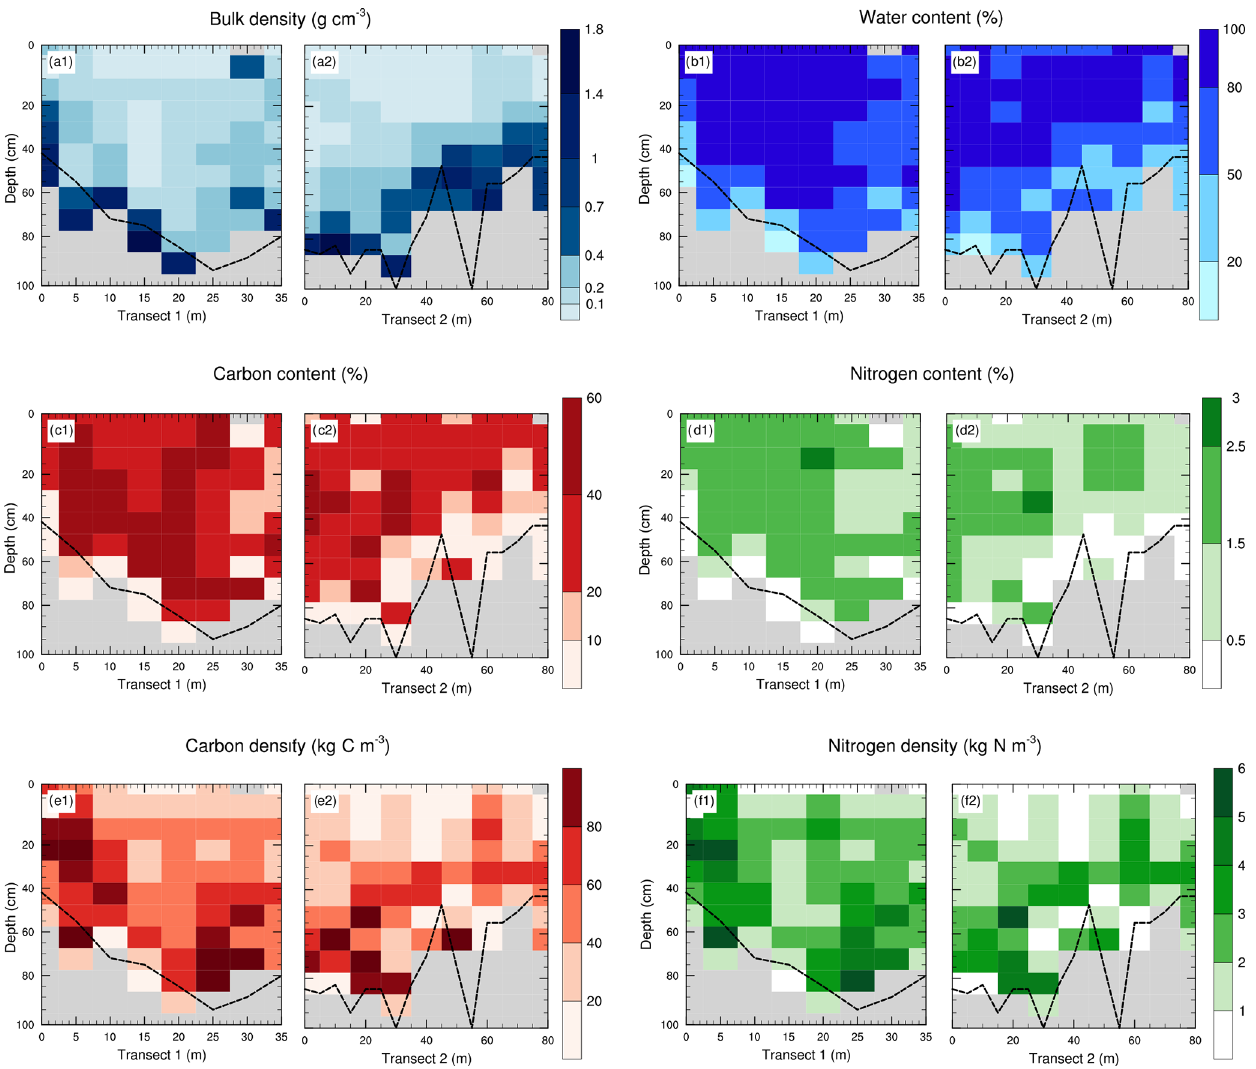
(gcm − 3 ), (b) soil water content (%), (c) soil carbon content f C (%), (d) soil nitrogen Figure 6. Soil profiles of (a) soil bulk density ρ obs bulk content f N (%), (e) soil carbon density ρ C (kgCm − 3 ), and (f) soil nitrogen density ρ N (kgNm − 3 ) along both transects. The dashed black line represents the measured organic–mineral interface. Grey zones indicate the absence of data (mineral